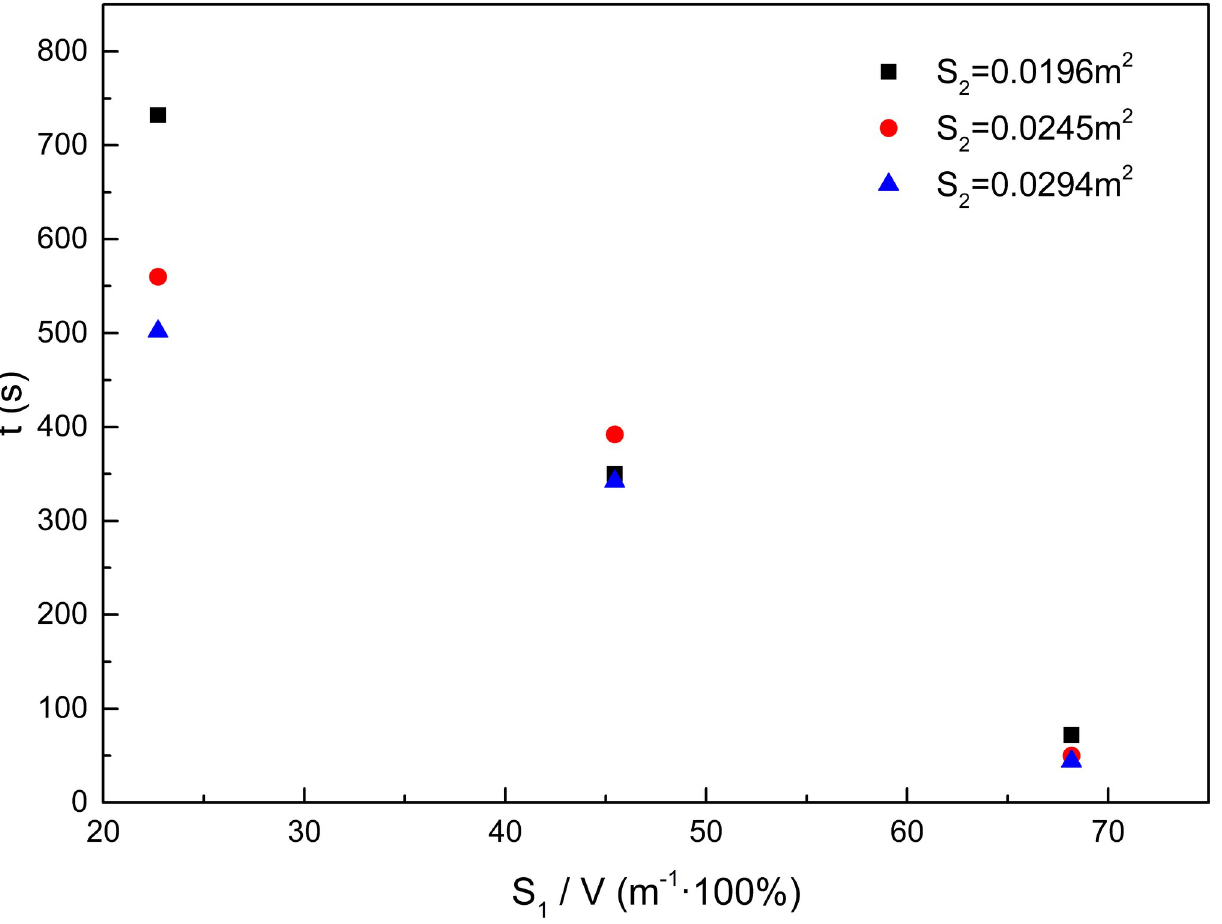
Fig 7. Effect of the compartment window area on backdraft